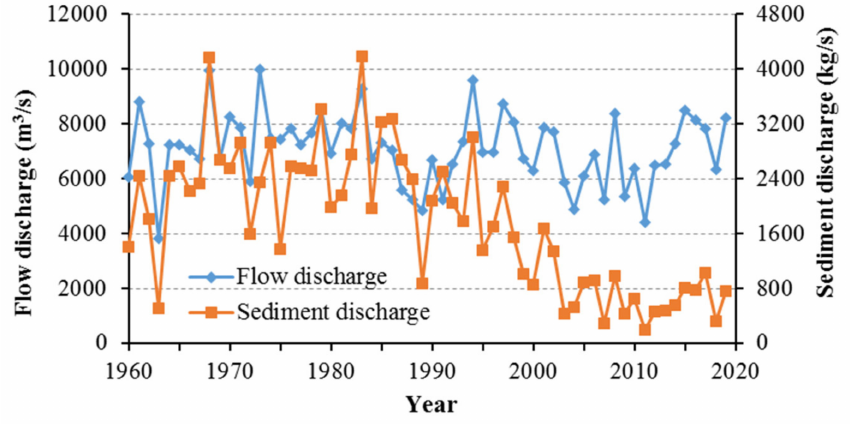
Figure 9. Annual mean value of flow and sediment discharges observed at Makou station since